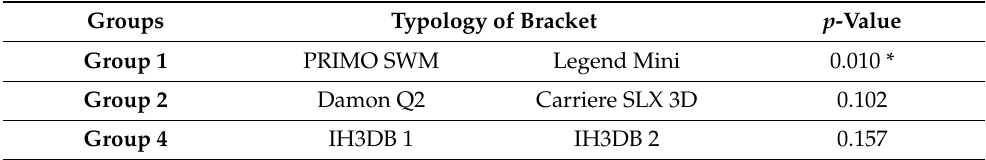
Table 5. Wilcoxon’s within-group comparative analysis of the bracket types 1, 2, and 4 ( p < 0.05 *).